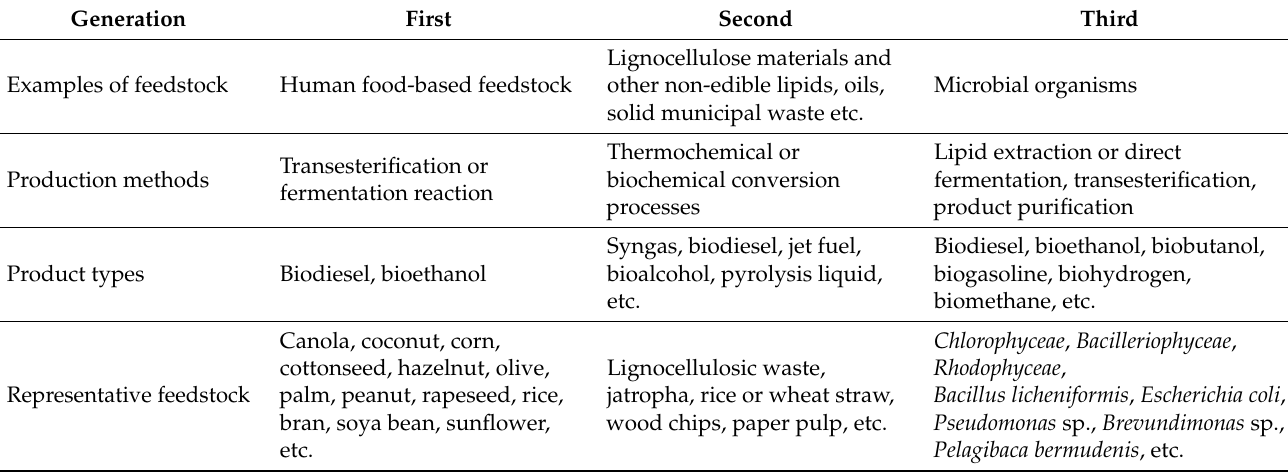
Table 4. Biofuel categories based on feedstock sources (adapted and modified from Lin and Lu [69]). Generation Examples of